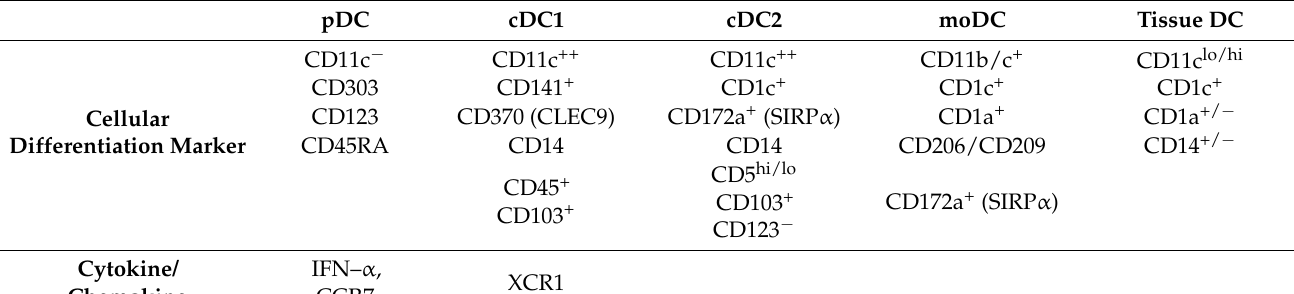
Table 4. Functional diversity of dendritic